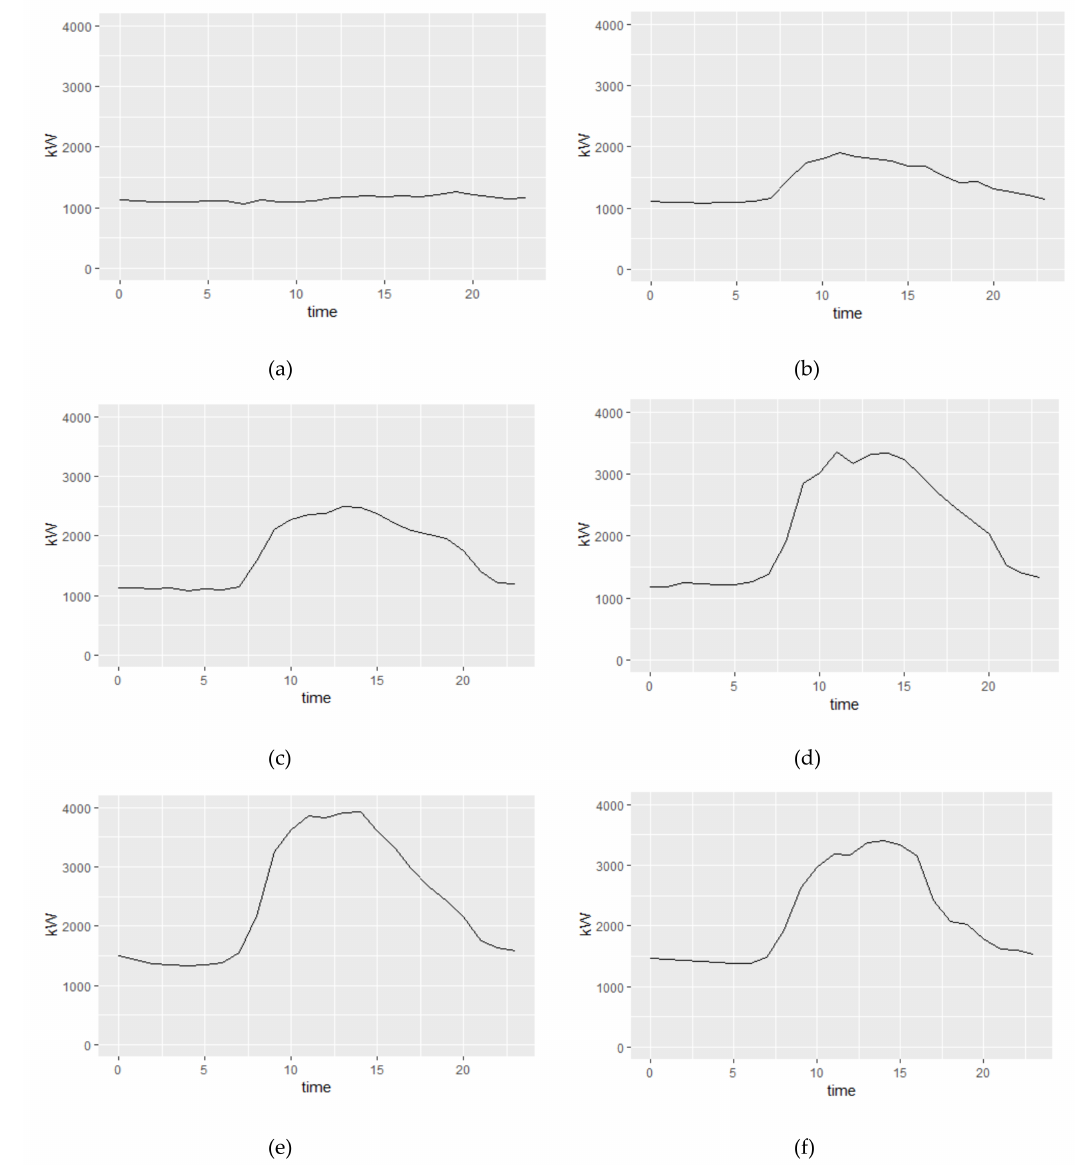
Figure 5. Electricity use at Chubu University for di ff erent electricity use periods: ( a ) Sundays and holidays, ( b ) Saturdays, ( c ) lecture days without air conditioning, ( d ) lecture days with air-conditioning, ( e ) lecture days with air-conditioning peak, and ( f ) non-lecture days with air-conditioning.